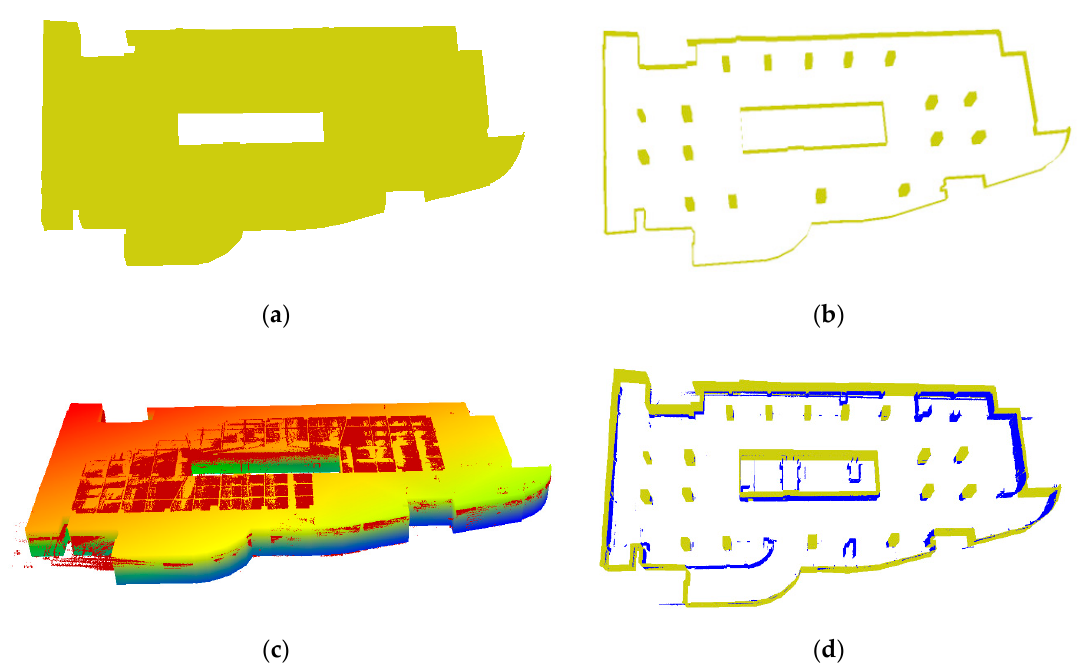
Figure 20. Structural model results of the parking lot at the Xiamen university ( a ) The structural model with slant floor and ceiling. ( b ) Vector model of walls and pillars. ( c ) Matching between point clouds and structured model. ( d ) Matching between point clouds and the vector model of walls and pillars.